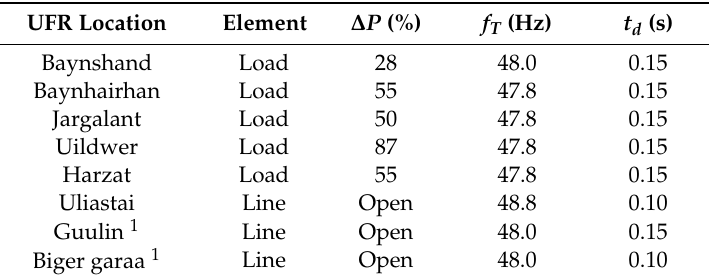
Table 2. Actual traditional UFLS settings of